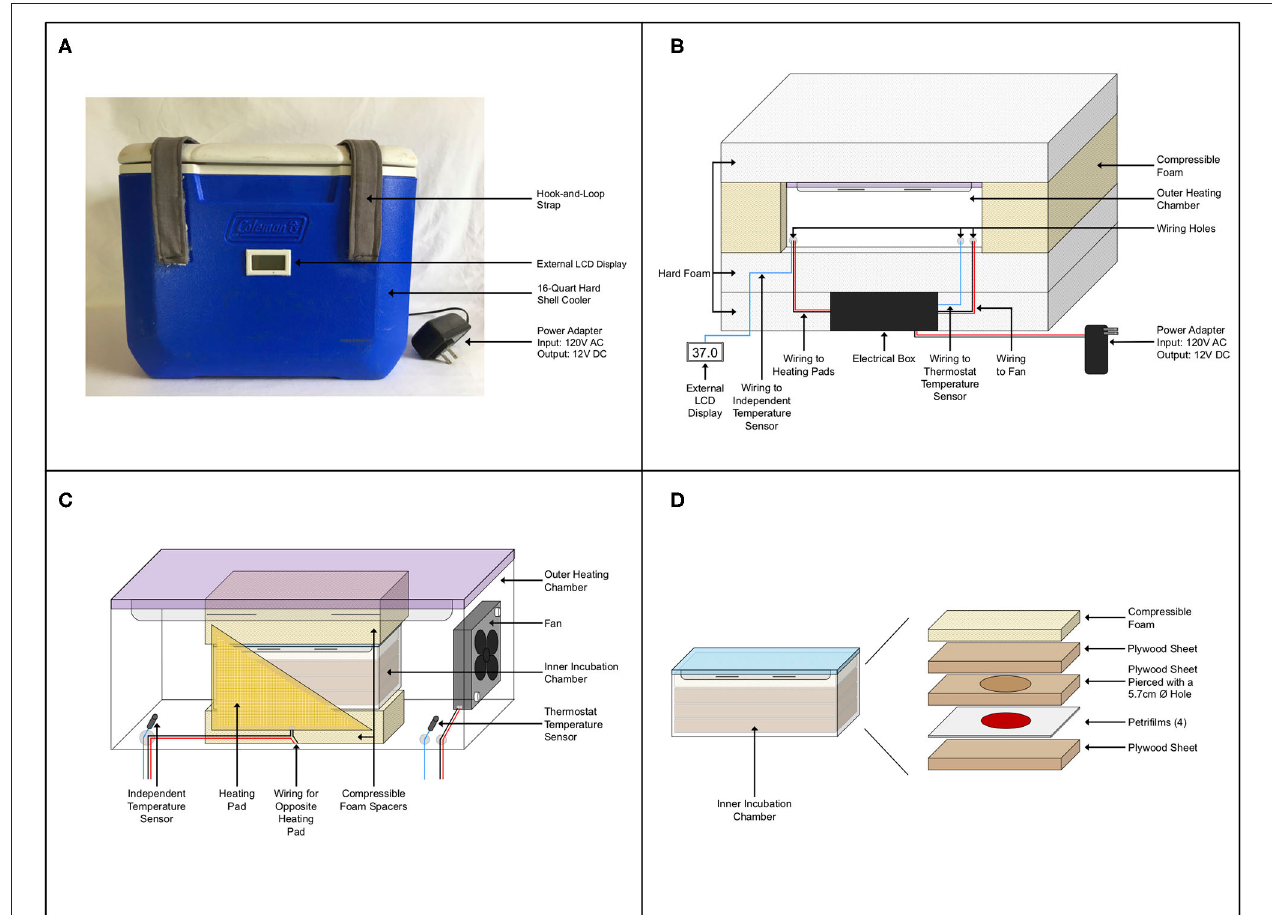
FIGURE 1 | Incubator schematics. (A) Outside view of the incubator. (B) Internal layout of the incubator showing the electrical control system, wiring, foam insulation, and outer heating chamber. (C) Outer heating chamber detailed with wiring to fan and heating pads and foam spacers at the top and bottom of the inner chamber. Heating pads are rectangular, a cut-out is shown to see detail inside of the chamber. (D) Exploded view of the inner incubation chamber